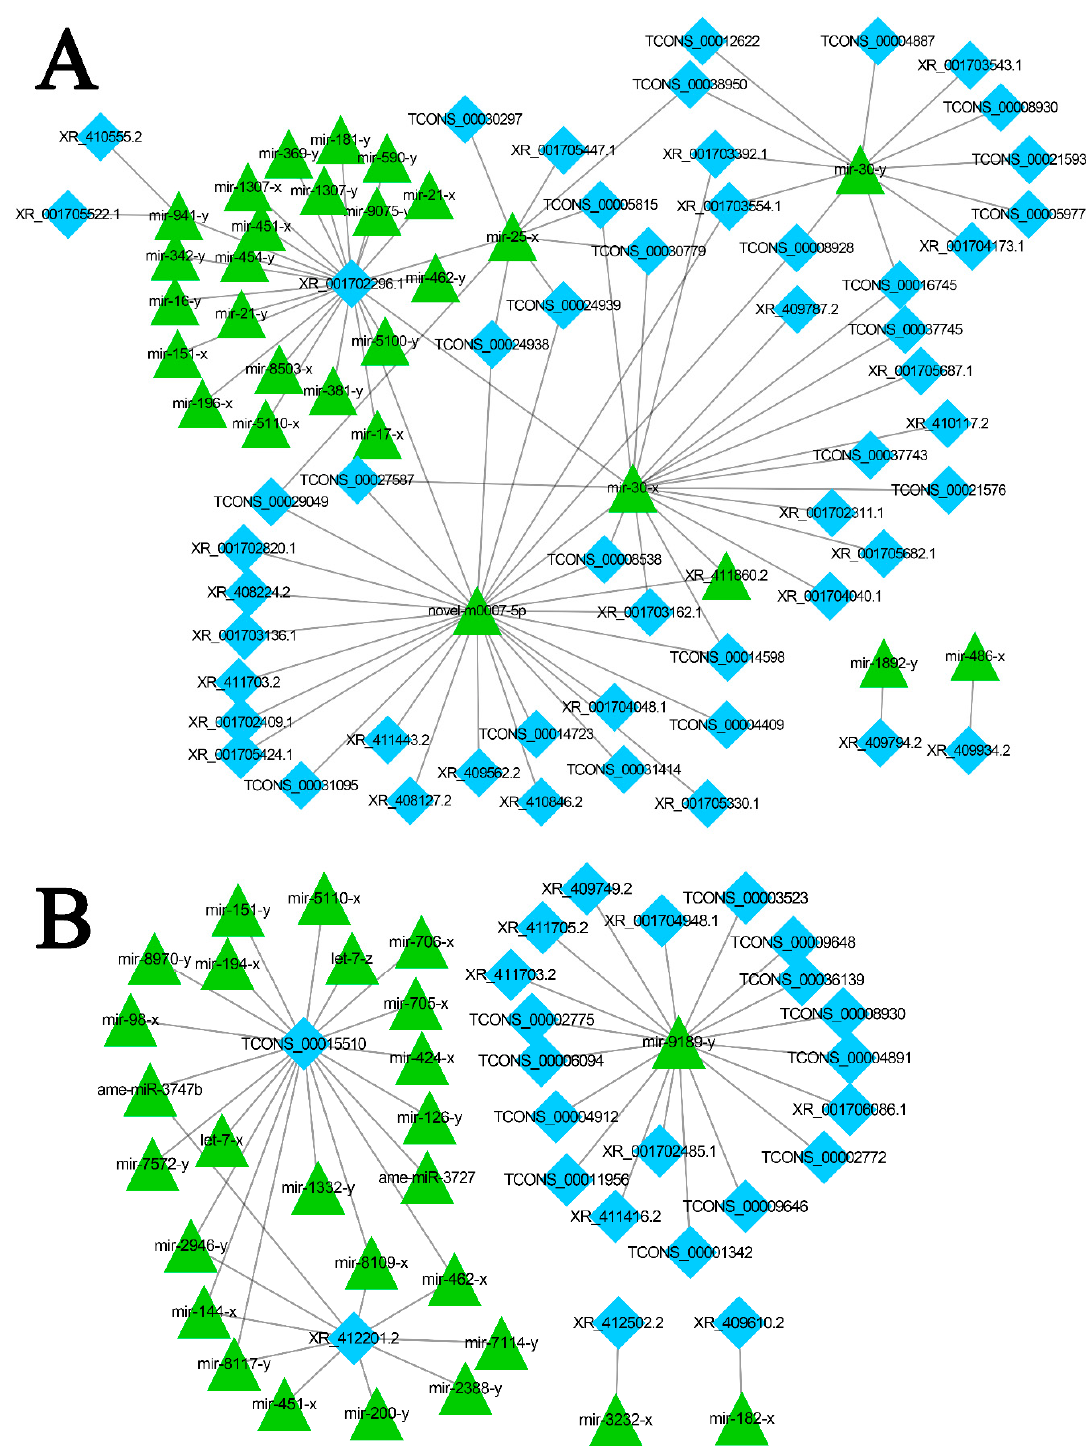
Figure 4. Competitive endogenous RNA (CeRNA) networks of DElncRNAs in N. ceranae -infected and normal midguts of A. m. ligustica workers. ( A ) ceRNA networks of DElncRNAs in Am7CK vs. Am7T. ( B ) ceRNA networks of DElncRNAs in Am10CK vs. Am10T. Diamonds indicate lncRNAs and triangles indicate miRNA.